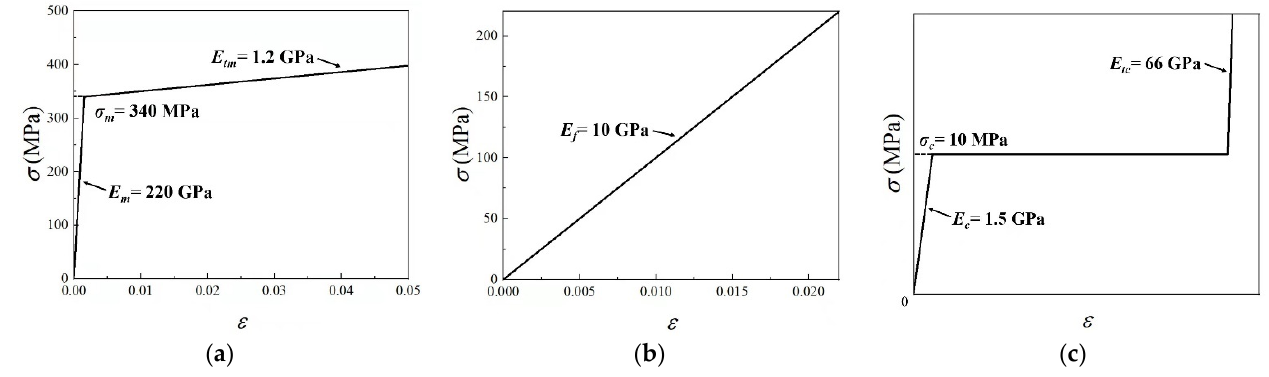
Figure 4. Material stress–strain curves used in FE calculations: ( a ) Metal layer of FML face sheets; ( b ) fiber-reinforced composite layer of FML face sheets; ( c ) metal foam core.